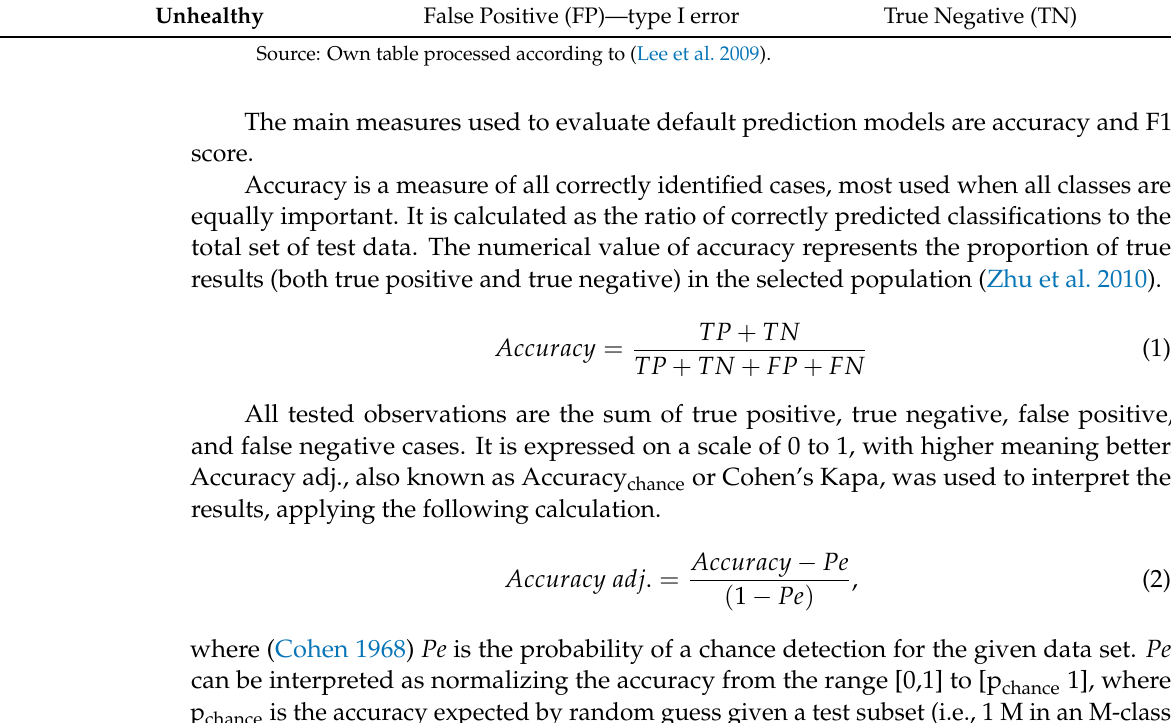
Table 3. Contingency table showing the number of positive and negative tests and type I and II errors. Estimates (Results Provided by Model) Healthy Unhealthy Healthy True Positive (TP) False Negative (FN)—type II error Reality